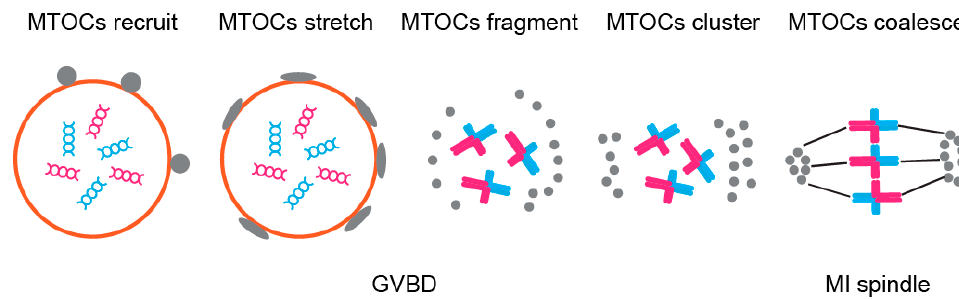
Figure 6. Asymmetrical MTOCs formation—MTOCs (grey) are recruited to nuclear envelope and are well stretched before NEBD. After NEBD, MTOCs are fragmented to small pieces and migrate to spindle poles. Then the MTOCs cluster to form spindle poles and nucleate microtubules in order to assemble the spindle.